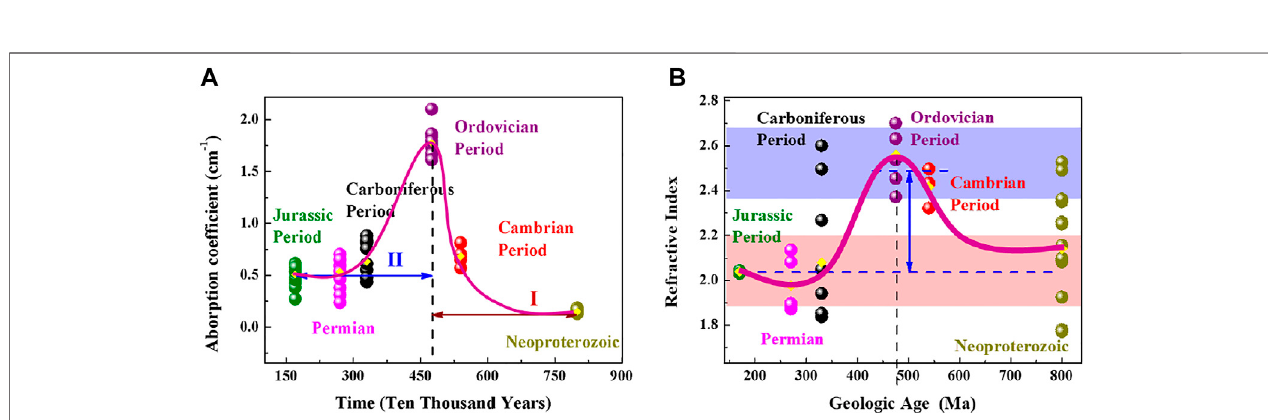
FIGURE 5 | (A) Variations in the absorption coef fi cient with geologic age; (B) Variations in the THz refractive index with geo-logic age.